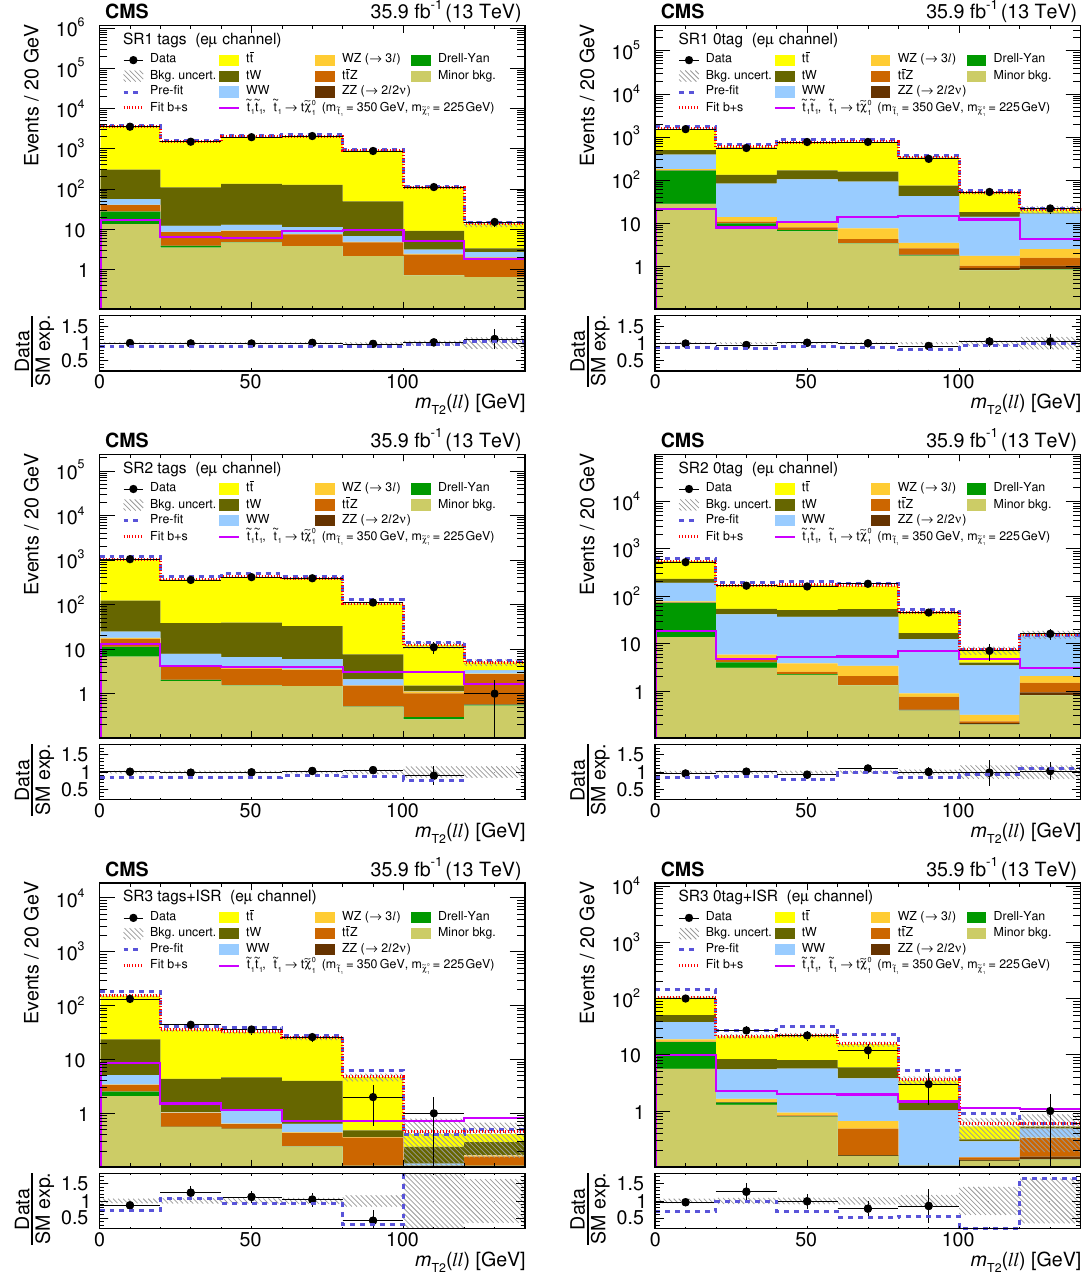
miss Figure 6 . Distributions of m < T2 ( ‘‘ ) after the (cid:12)t to data in the top squark SRs with 140 < p T 200 GeV (upper plots), 200 < p miss < 300 GeV (middle), or p miss > 300 GeV (lower), for DF events T T with b-tagged jets (left plots) and without b-tagged jets (right plots). The solid magenta histogram shows the expected m T2 ( ‘‘ ) distribution for top squark pair production with m = 350 GeV and e t 1 m = 225 GeV. Expected total SM contributions before the (cid:12)t (dark blue dashed line) and after e (cid:31) 0 1 a background+signal (cid:12)t (dark red dotted line) are also shown. The last bin includes the over(cid:13)ow entries. In the bottom panel, the ratio of data and SM expectations is shown for the expected total SM contribution after the (cid:12)t using the background-only hypothesis (black dots) and before any (cid:12)t (dark blue dashed line). The hatched band represents the total uncertainty after the (cid:12)t.